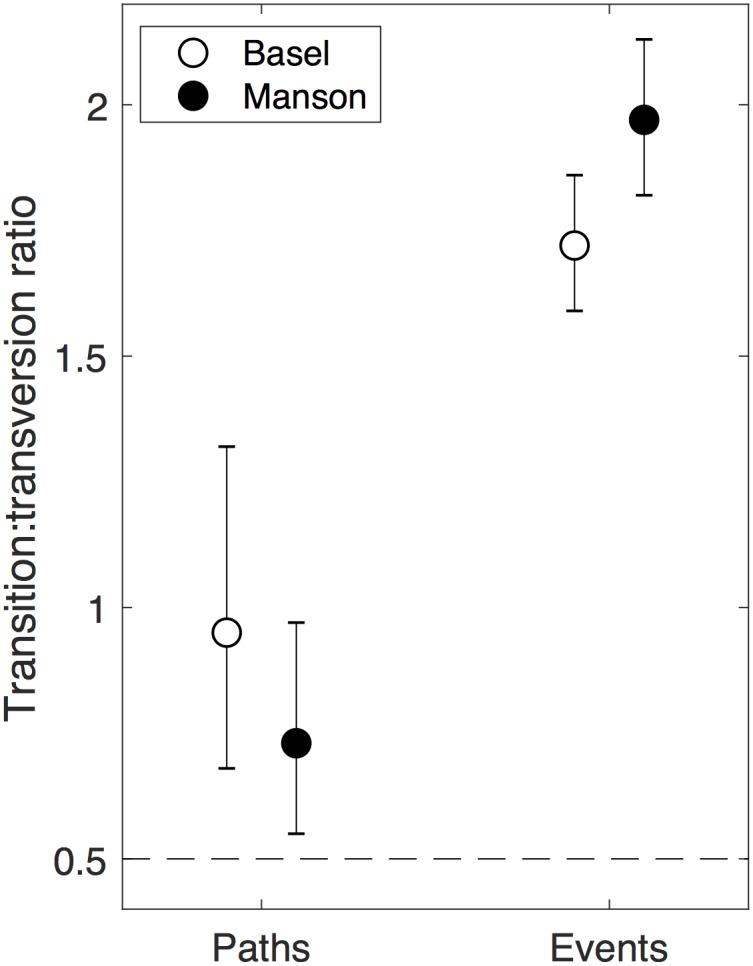
Transition bias in mutational paths and mutational events in the Basel and Manson data sets.Symbols represent transition:transverion ratios (Basel paths: 74:78, empirical P value = 7.1 × 10−5; Manson paths: 88:120, empirical P value = 4.2 × 10−3; Basel events: 1,755:1,020, empirical P value < 10−6; Manson events: 1,771:900, empirical P value < 10−6). Error bars represent 95% binomial confidence intervals. The dashed horizontal line shows the null expectation of the transition:transversion ratio, assuming our default null model that one transition occurs for every two transversions and that all mutations are independent. For additional null models used at the level of events, see the main text. The data visualized in this and all subsequent figures are presented in numerical form in S1 Data.